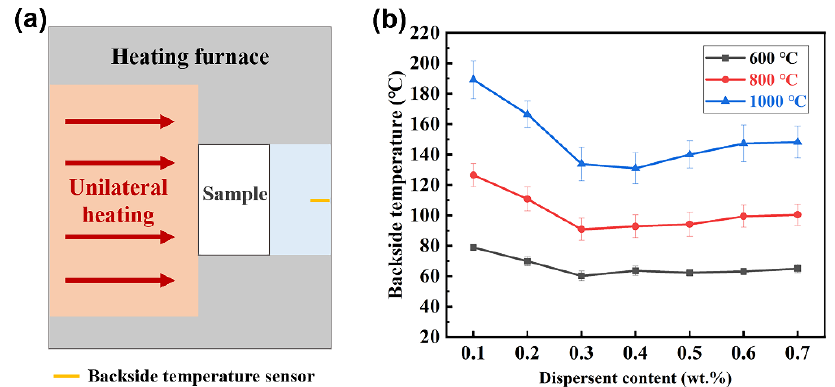
Figure 12. ( a ) Testing principle of the single-surface heating furnace. ( b ) Backside temperatures of SiO 2 fibrous porous materials with different SHMP contents.